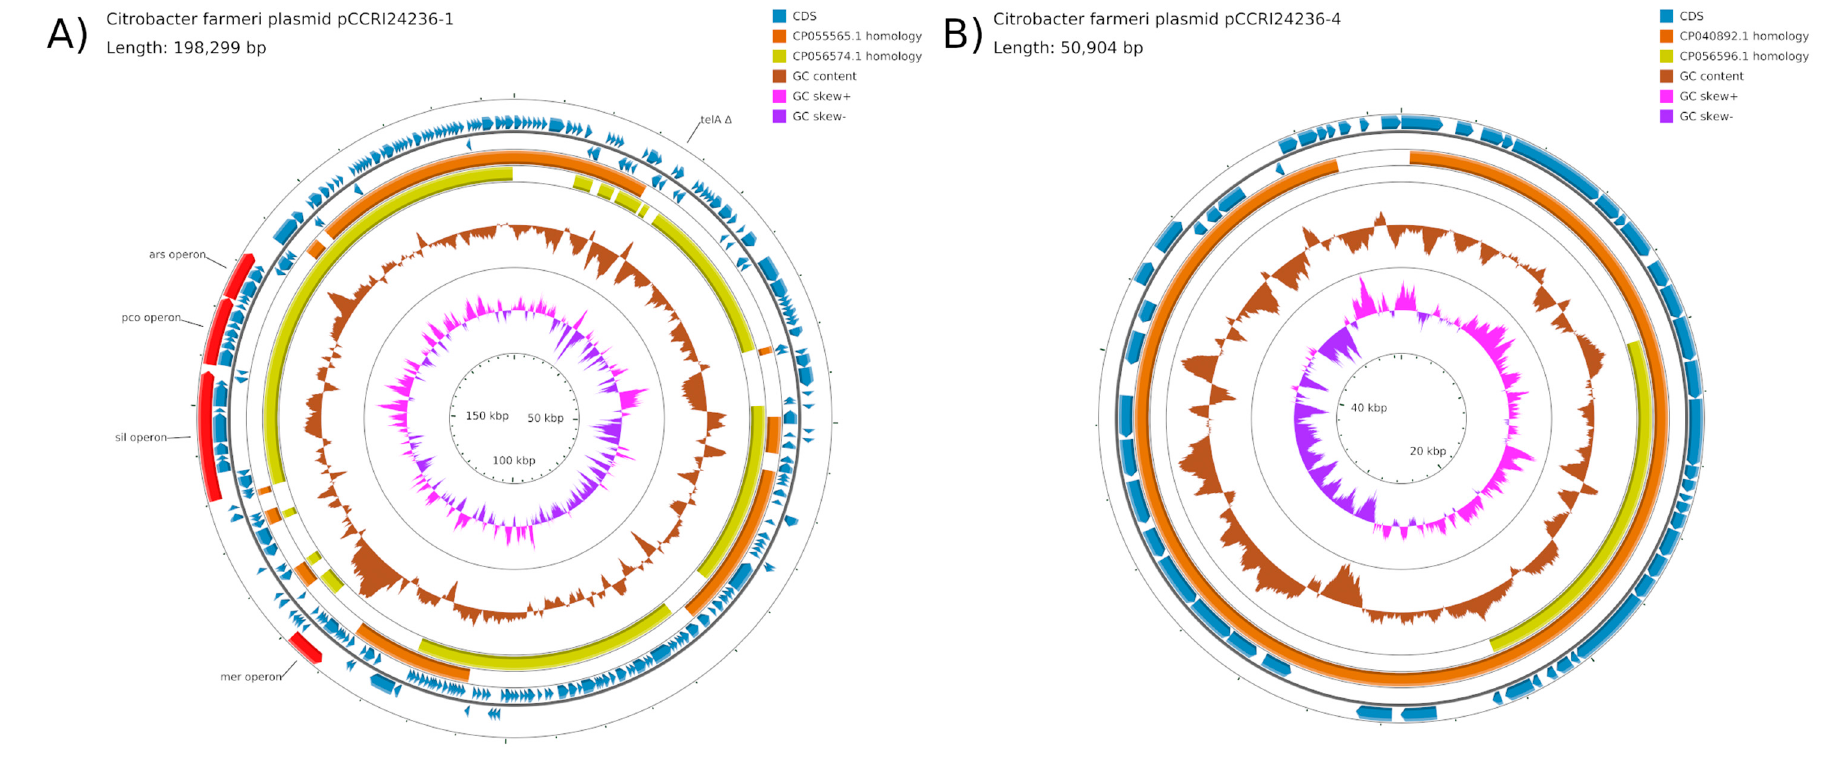
Figure 3. Map of plasmids pCCRI24236-1 ( A ) and pCCRI24236-4 ( B ). The scales are indicated on the innermost circles. The second circles are G+C skew in pink (+) and purple ( − ), and circles 3 show G+C content (deviation from the average) in brown (+, outward and − , inward). The next two circles illustrate regions homologous to related plasmids. The following two circles show positions of CDSs in minus (circle 6) and plus (circle 7) strands in dark blue.